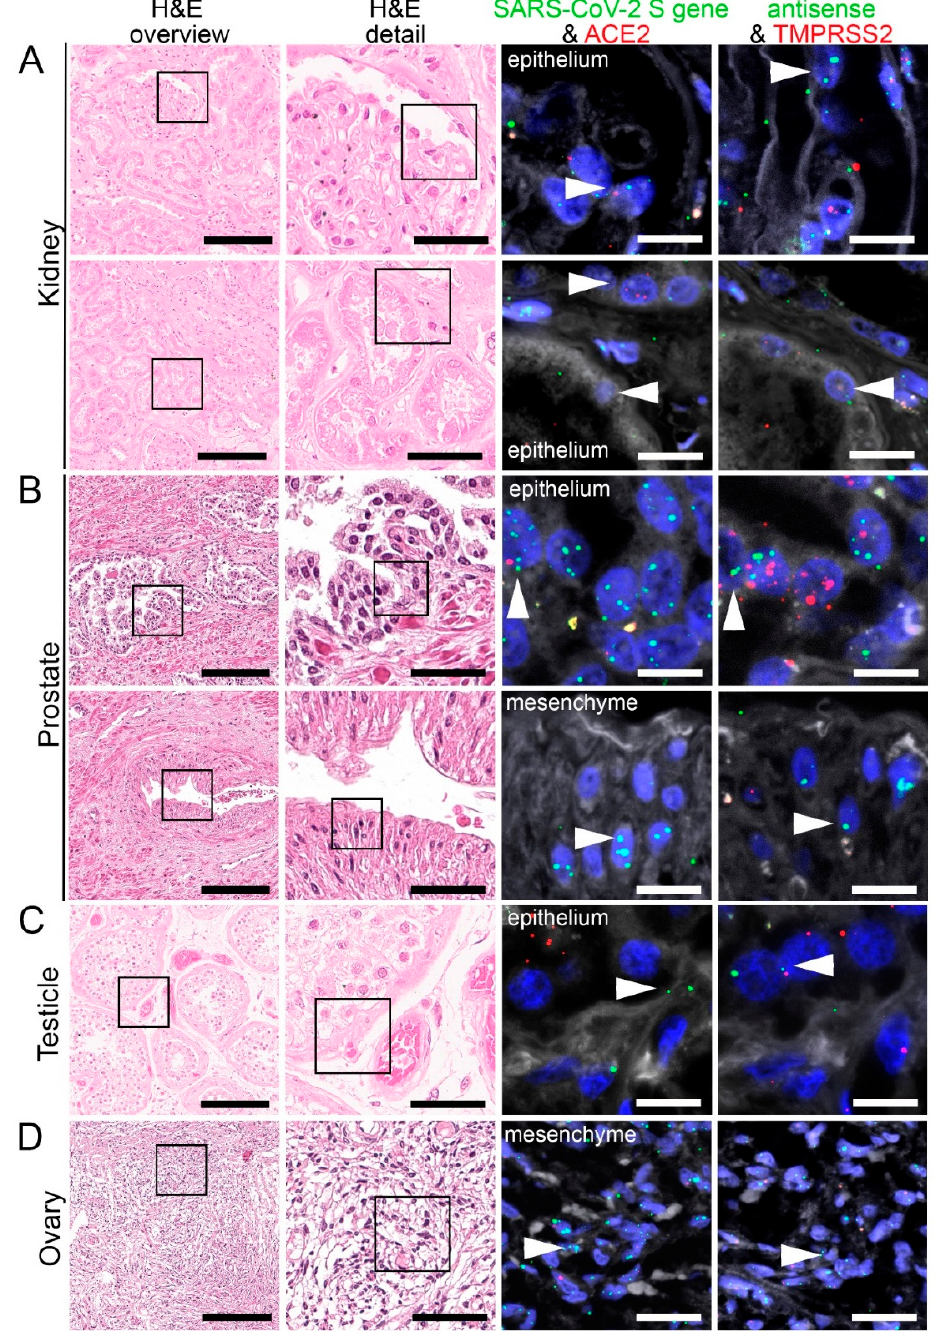
Figure 6. Virus detection in urogenital tract autopsy tissue by FISH. HE stained tissue and repre- sentative image sections showing FISH co-visualization of RNA sequences either of SARS-CoV-2 S gene genomic RNA (green, arrowhead) and ACE2 (red) or SARS-CoV-2 antisense strand RNA as an indicator of replicating virus (green, arrowhead) and TMPRSS2 (red) in the kidney ( A , upper panel: glomerular visceral epithelial cells/podocytes; lower panel: tubular epithelial cells), prostate ( B , upper panel: glandular epithelial cells; lower panel: vascular smooth muscle cells), testicle ( C , germinal epithelium) and ovary ( D , mesenchymal stromal cells). Scale bars represent 200, 50 and 20 µm ( A , C , D ) or 10 µm ( B ), respectively.